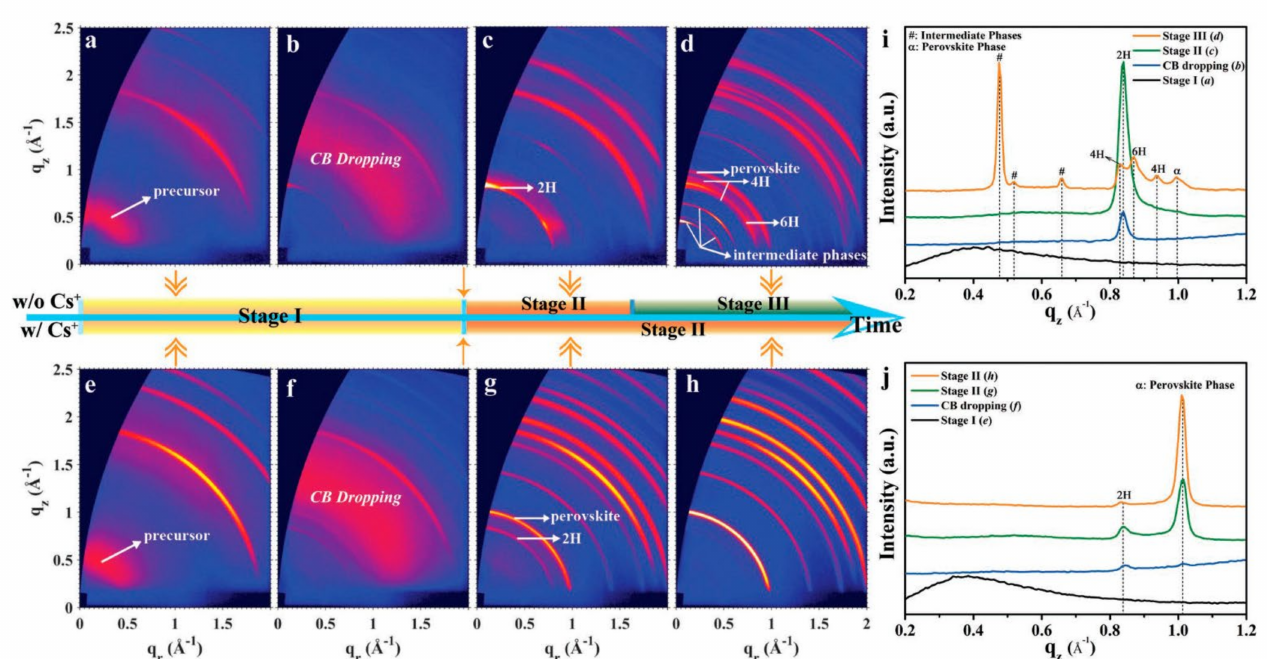
Figure 4. Different crystallization stages versus spinning time for perovskite formations without and with Cs + ( a – d ); 2D GIWAXS patterns at different crystallization stages for films without Cs + and with 10% Cs + ( e – h ); ( i , j ) the intensity profiles along the q z direction for films without Cs + ( i ) and with 10% Cs + ( j ). Reprinted with permission from Ref. [56]. Copyright 2019 John Wiley &